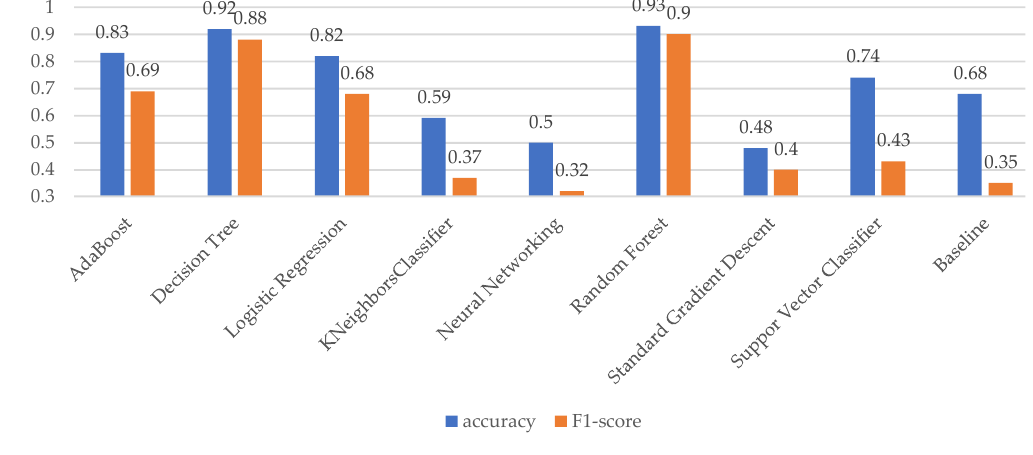
Figure 3. Average accuracy and F1-score per model.